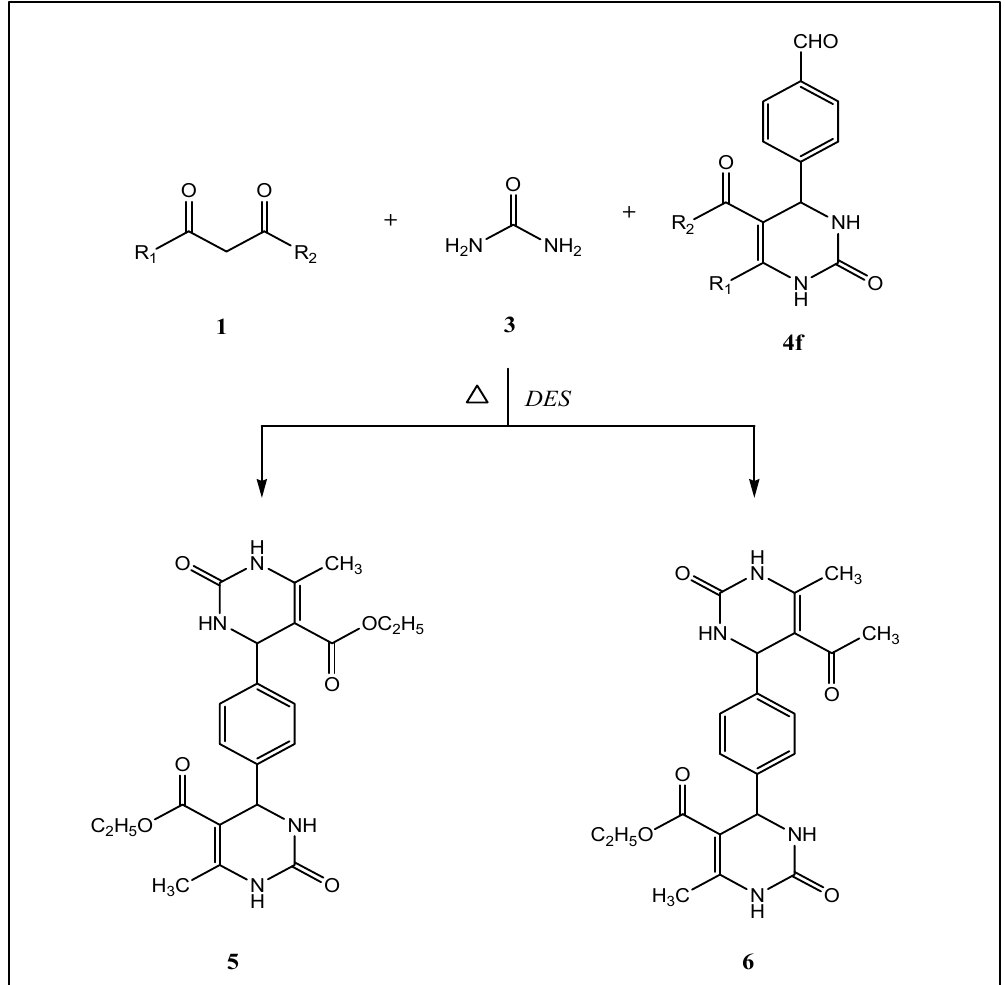
Table 2. Synthesis of bis-3,4-dihydropyrimidin-2( 1H )-one. Entry * R 1 R 2 Products Reaction Yield #